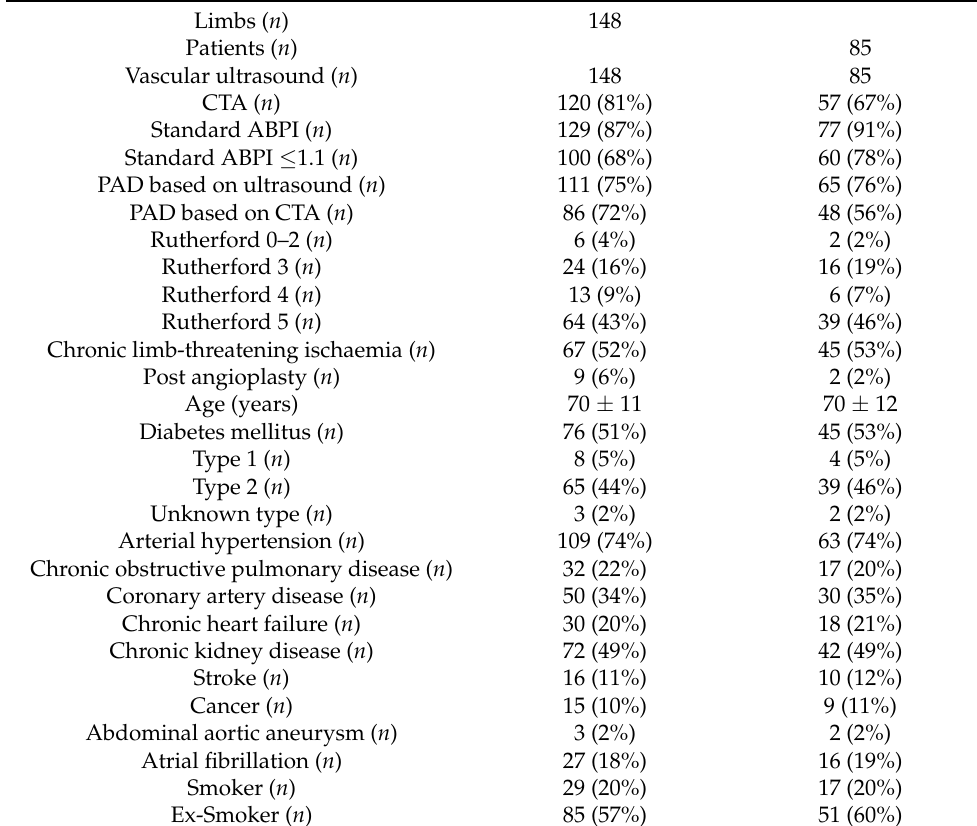
Table 1. Characteristics of patients in study 3. (mean ± standard deviation; ABPI = ankle brachial pressure index, CTA = computed tomography angiography, eABPI = estimated ankle brachial pressure index, PAD = peripheral artery